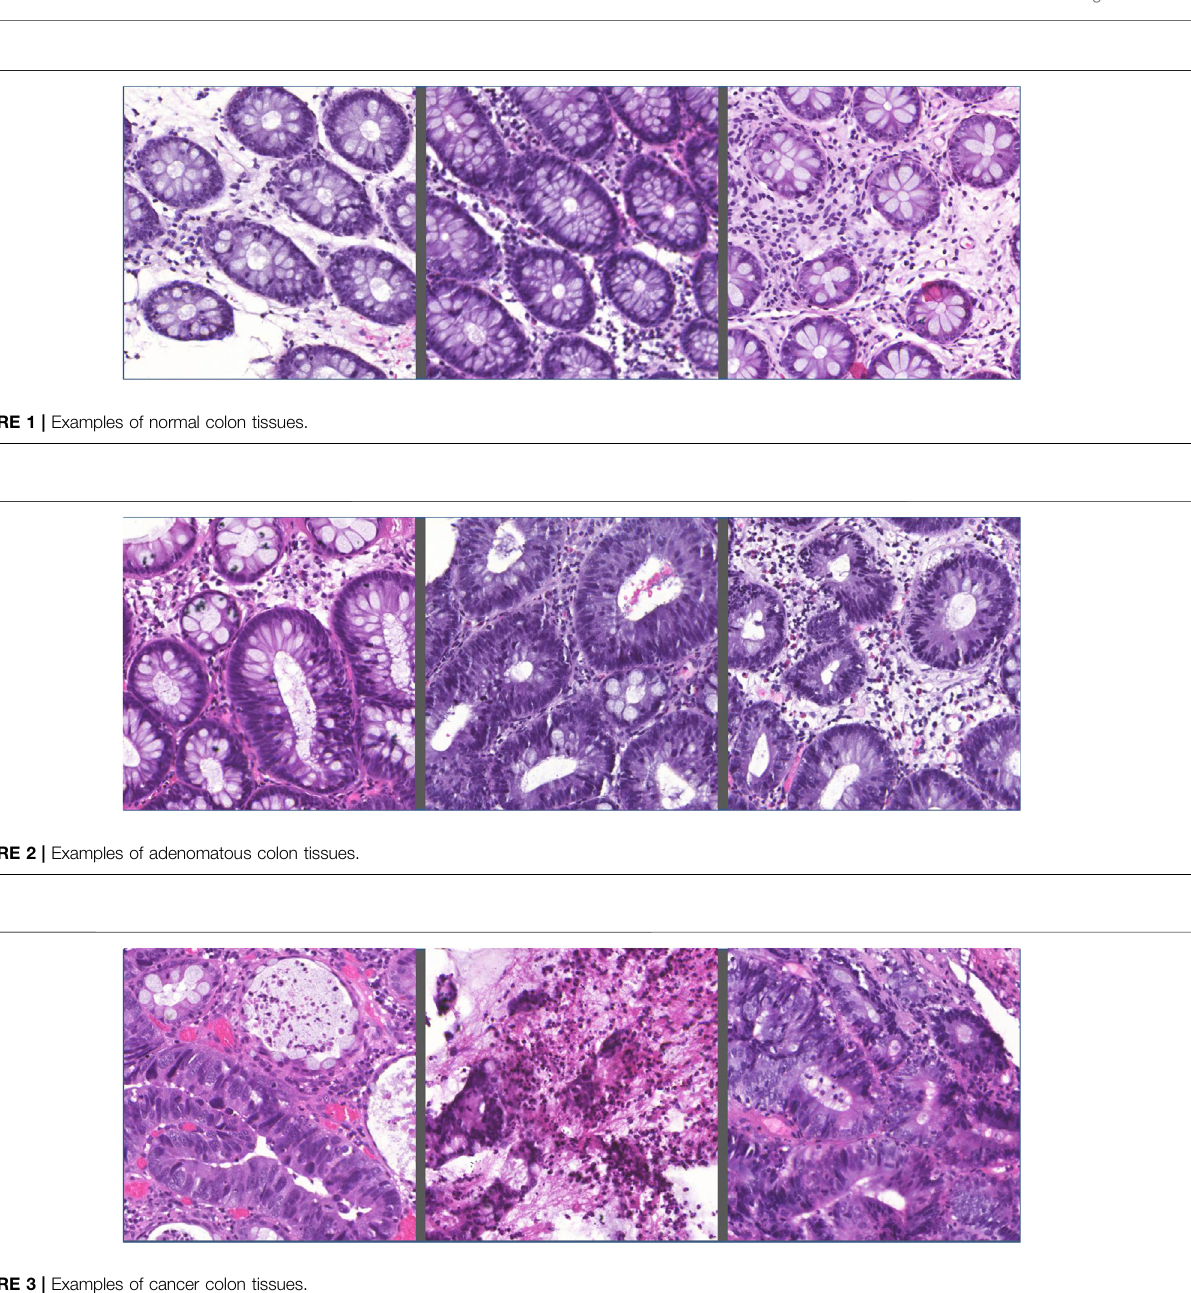
FIGURE 3 | Examples of cancer colon